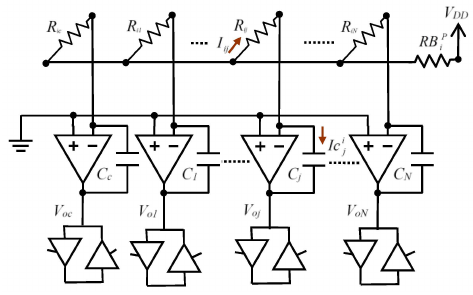
Figure 4. Equivalent circuit to scan the values of the resistors of row i